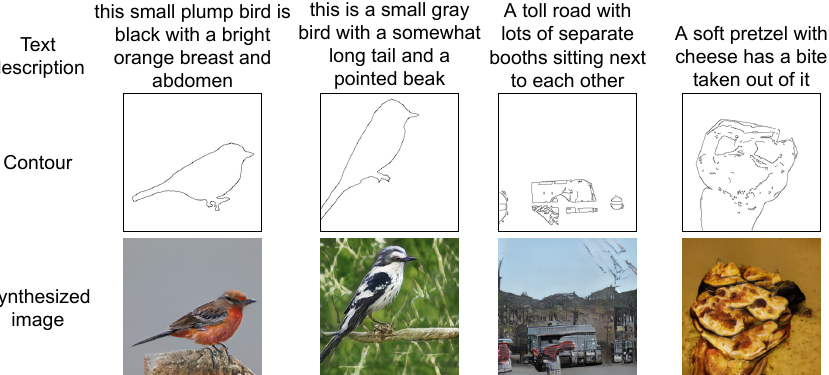
Figure 4. The customized synthesis results based on text and contour are shown above. The shape of the synthesized image is determined by the input contour, and the detailed content is determined by the text